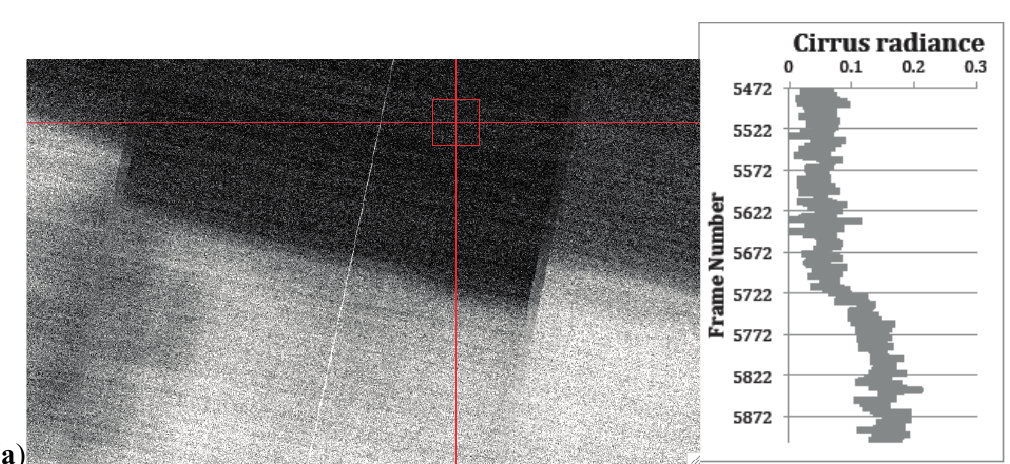
Figure 13. ( a ) Subset of a geometrically corrected Cirrus band image over the coast of Northern Africa showing odd and even FPM misalignment, with the associated along track profile (along the vertical red line in the image subset); ( b ) Same Cirrus image as (a) but geometrically corrected as if it were the SWIR1 band; and ( c ) SWIR1 band image of the same region and associated along track profile. Profiles are in units of W/m 2 sr μ